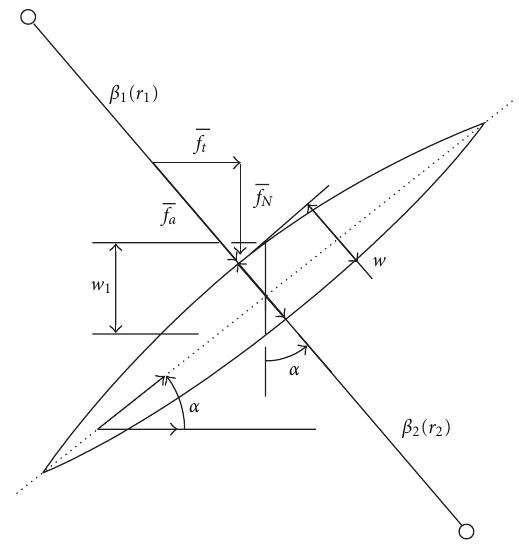
Figure 3: Overlap region showing normal and oblique